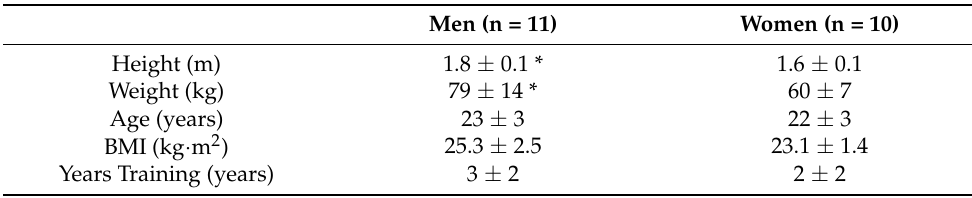
Table 2. One-repetition maximum (1RM) for all resistance exercises utilized for both active men and women (n = 21). Men (n = 11) Women (n = 10) Leg Press (kg) 169 ± 34 * 106 ± 17 Lat Pulldown (kg) 140 ± 23 * 79 ± 13 Chest Press (kg) 145 ± 26 * 64 ± 20 Leg Curl (kg) 88 ± 21